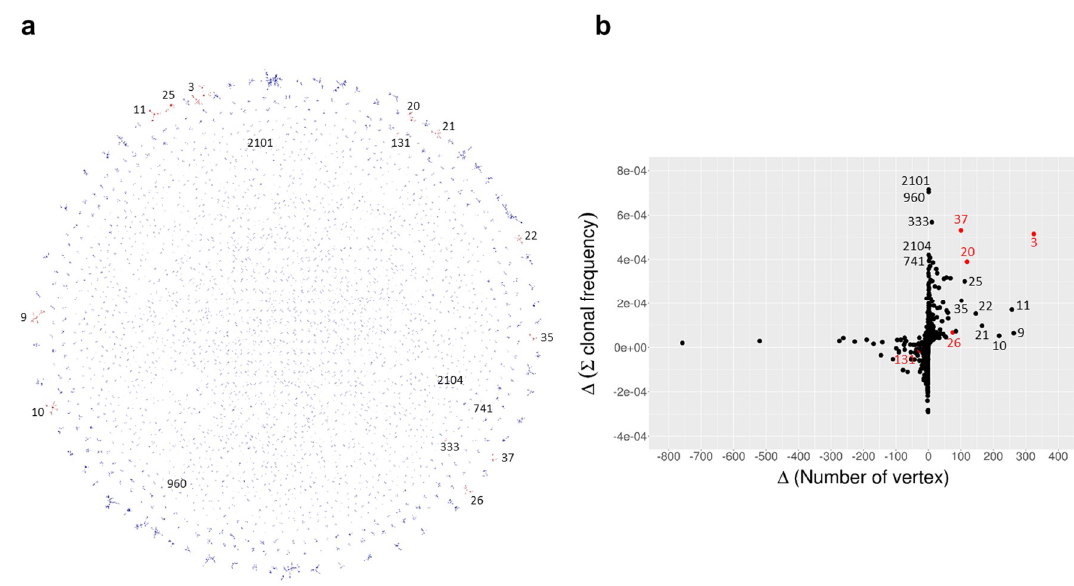
Figure 2. Characteristics of V H components. ( a ) Network image of V H components. The vertices in all four sets were connected by finding minimum spanning trees. The diameter of the vertex was drawn depending on the highest clonal frequency among the four sets. Components composed of a single vertex were excluded. Components showing significant increase in the number of vertex and/or clonal frequency from week 0 to week 5 were arbitrarily selected in the scatter plot ( b ) and drawn in brown. In the scatter plot, components confirmed to contain human hepatocyte growth factor (HGF)-reactive clones are labeled in red. All the other components are labeled in black.